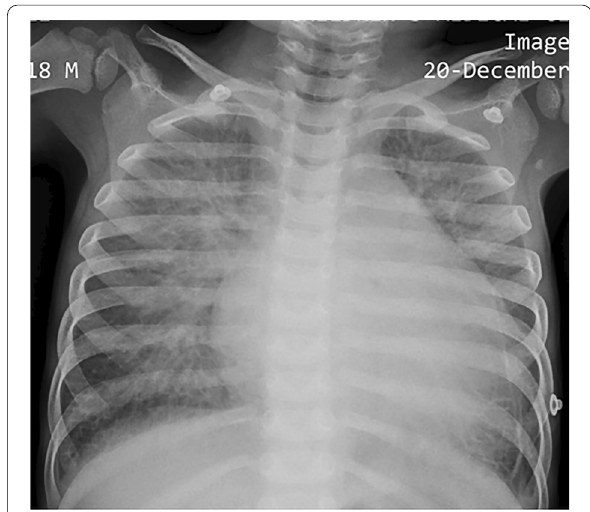
Fig. 1 Chest X-ray of the patient showing cardiomegaly and pulmonary congestion